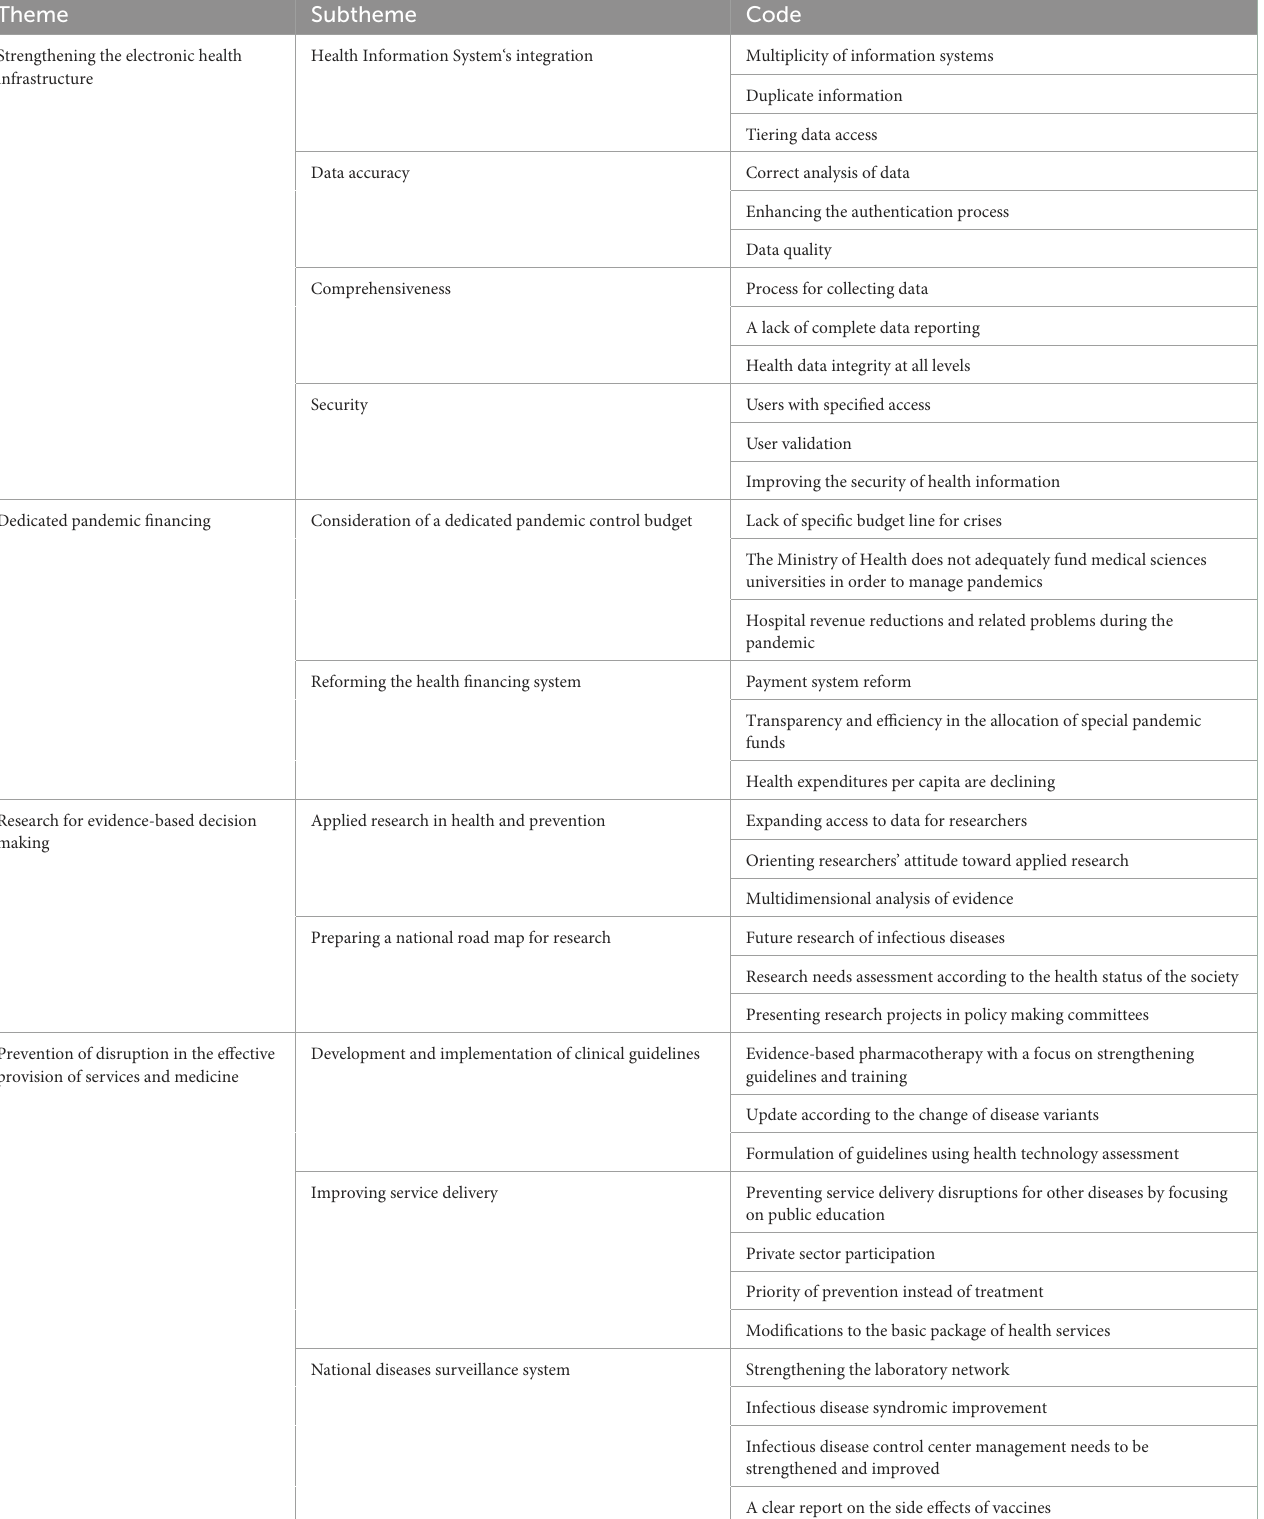
TABLE 2 Identified challenges that required changes in Iran’s healthcare